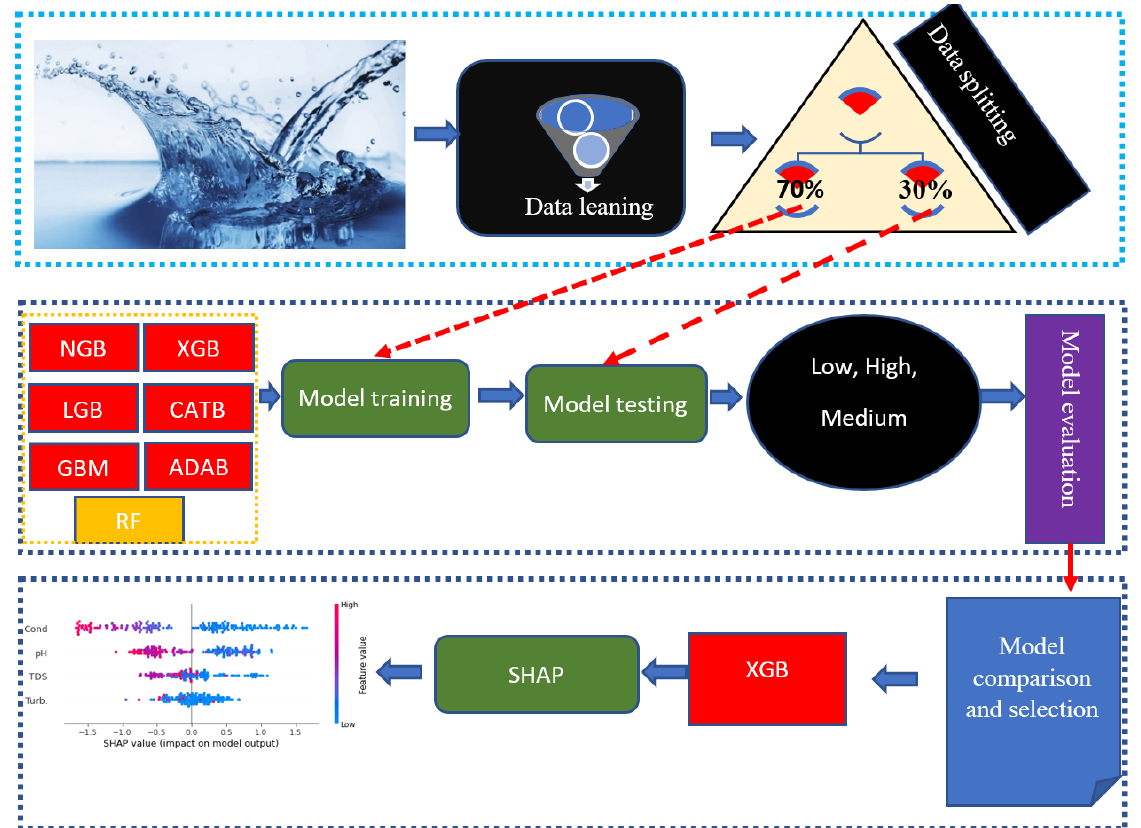
Figure 2. Model development and workflow of the study.